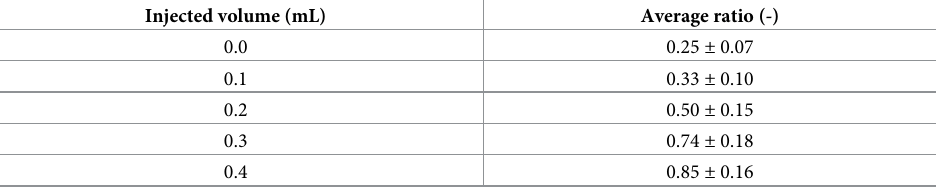
Table 2. Minor-to-major principal axes ratio in the segmented balloon. The figures correspond to worst-case esti- mates, as the balloon would typically inflate from the equatorial region at low volumes but the major axis could not be accurately determined due to the limits in imaging